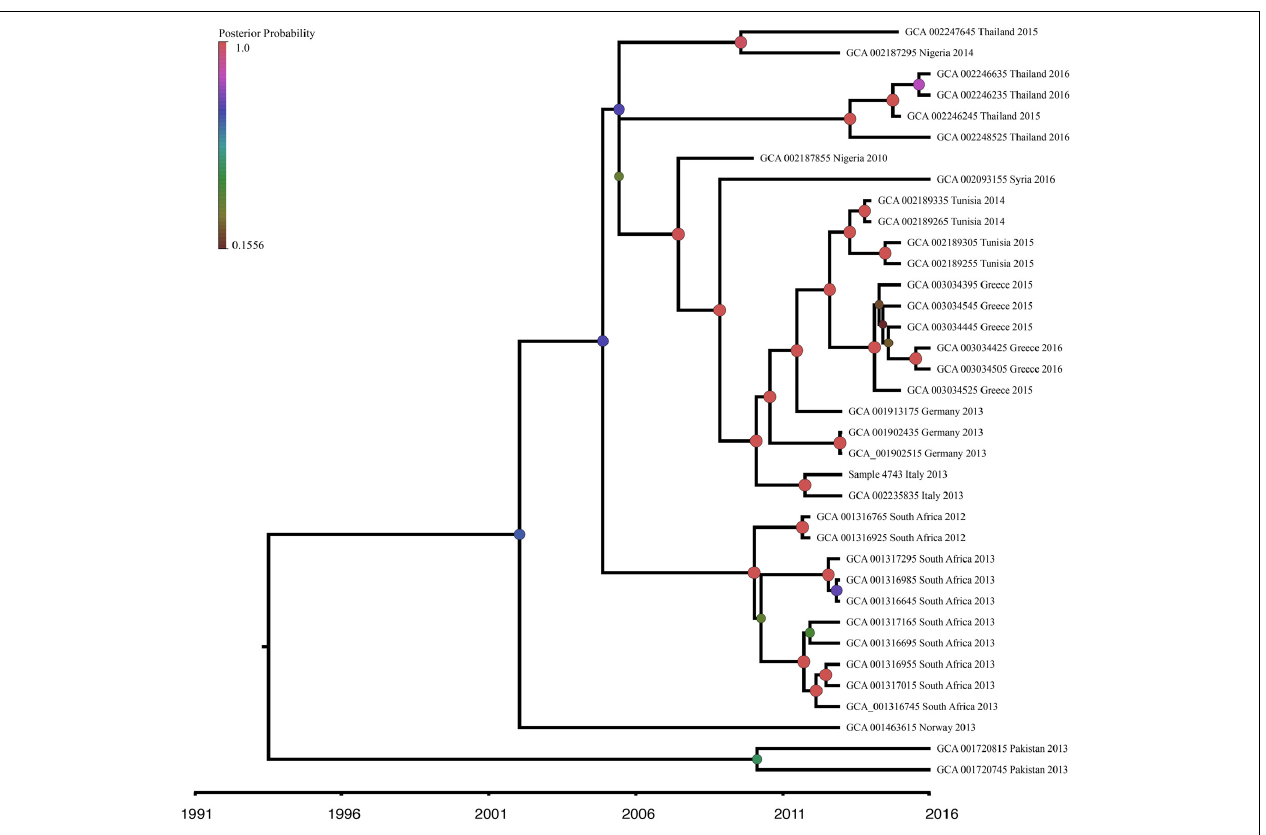
FIGURE 5 | Bayesian phylogenetic analysis of K. pneumoniae ST101 isolates. Beast v1.8.4 was used to produce a calibrated maximum clade credibility (MCC) phylogeny. The analysis was performed on WGS data from 36 K. pneumoniae ST101 genomes. Posterior probabilities are indicated by node size and color. The timeline represents years before the